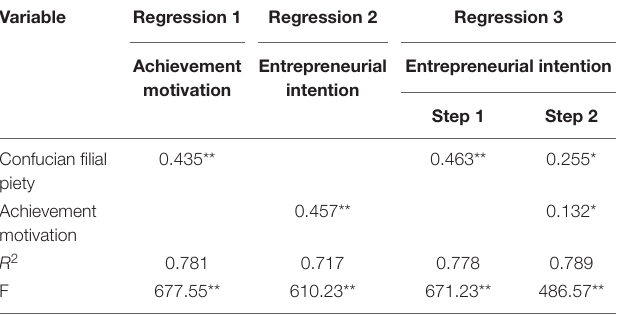
TABLE 6 | Mediation role of achievement motivation.